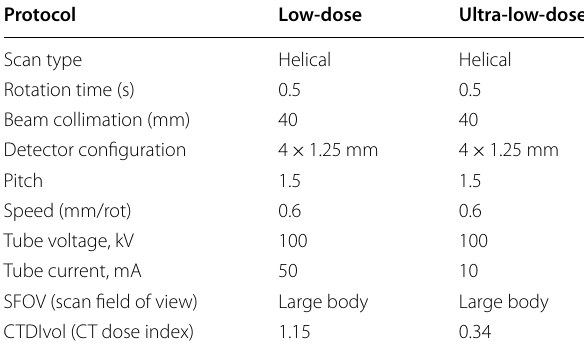
Table 1 Scan parameters of low‑dose and ultra‑low‑dose